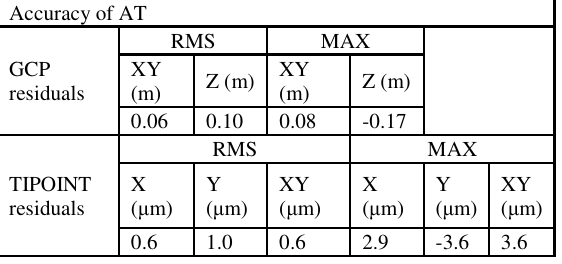
Table 2. Accuracy of GCPs & tie points